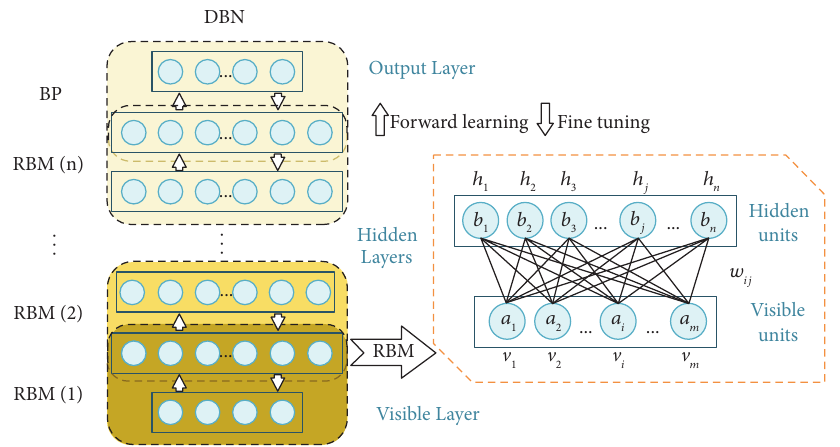
Figure 1: The structure diagram of DBN and